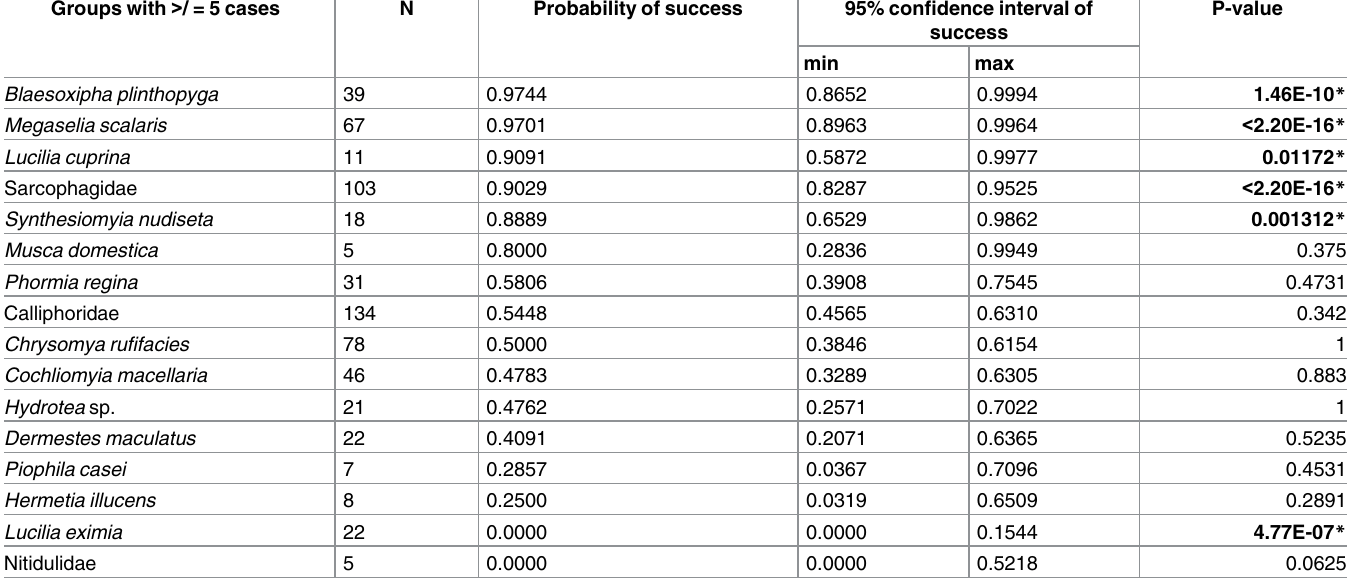
Table 4. Binomial test results suggesting indoor or outdoor scene